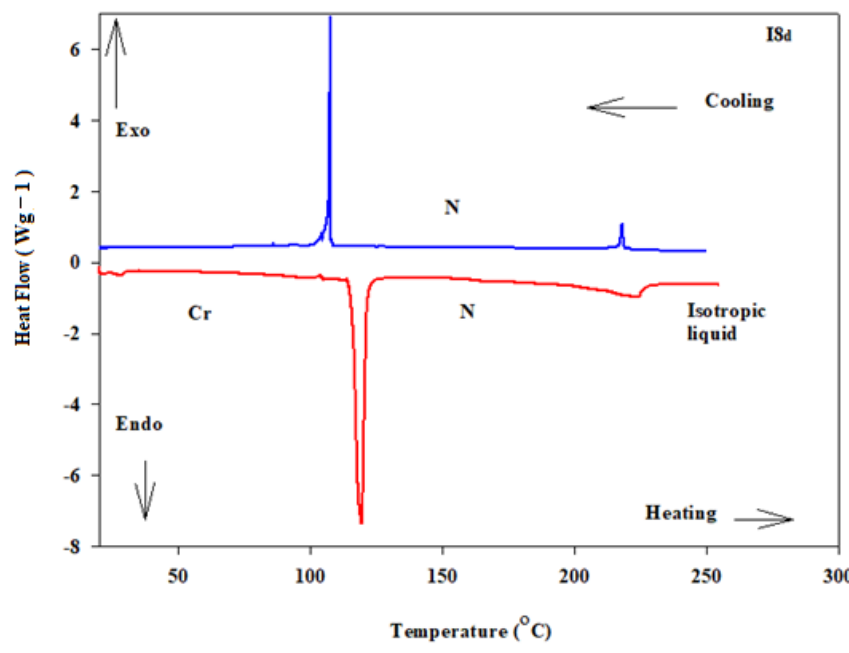
Figure 1. DSC thermograms captured from the second heating/cooling scan at heating rate 10 °C/min of compound I8 d .